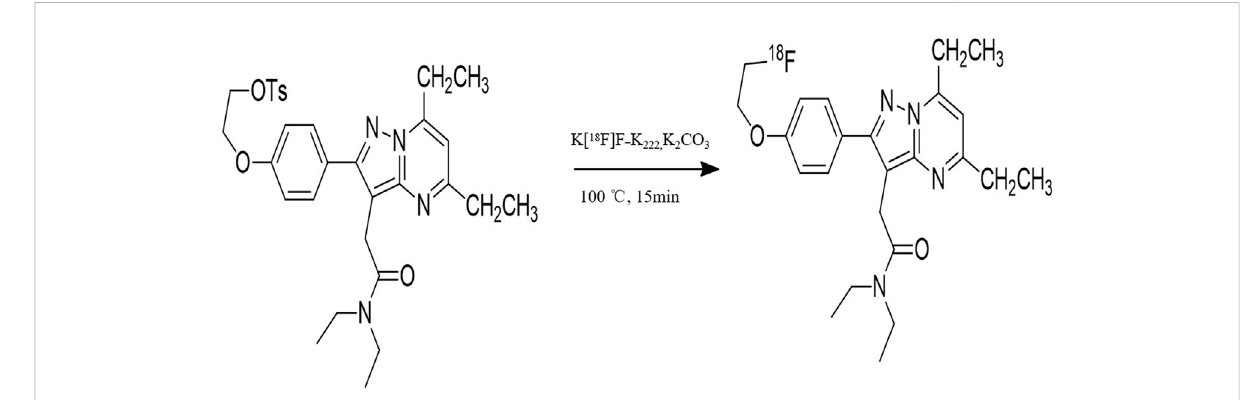
FIGURE 1 Synthetic scheme of 18